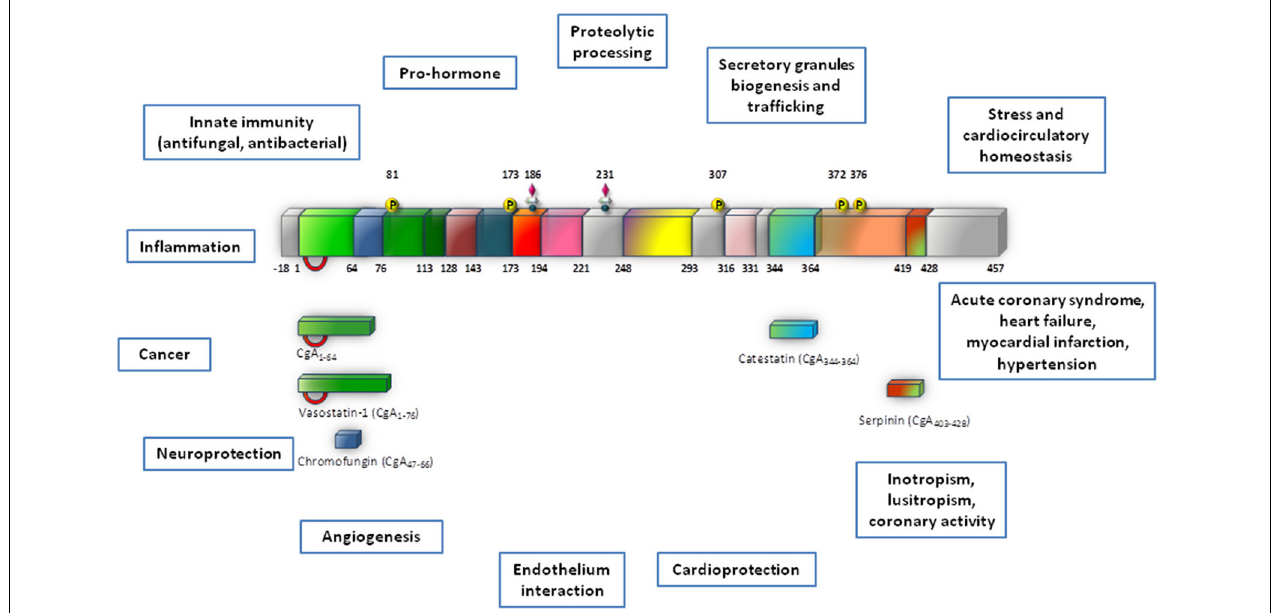
FIGURE 1 | This synopsis illustrates Chromogranin-A (CgA) processing and biological activities which are reviewed in this volume (modified from Angelone and Tota, 2012). This provides a cardiovascular dimension for CgA, with important outcomes in terms of biology, physiology and